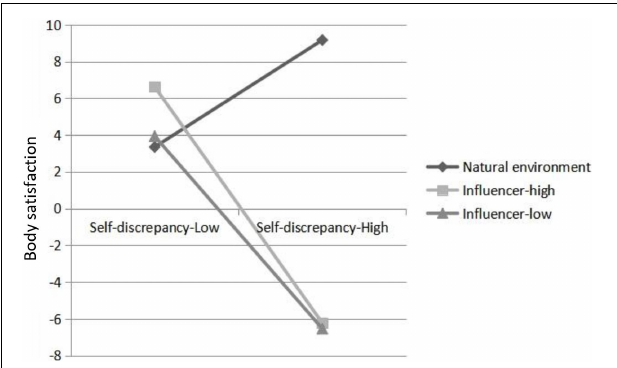
FIGURE 1 | Interaction effects of image types and self-discrepancy on body satisfaction. Error bars represent 95% confidence interval.